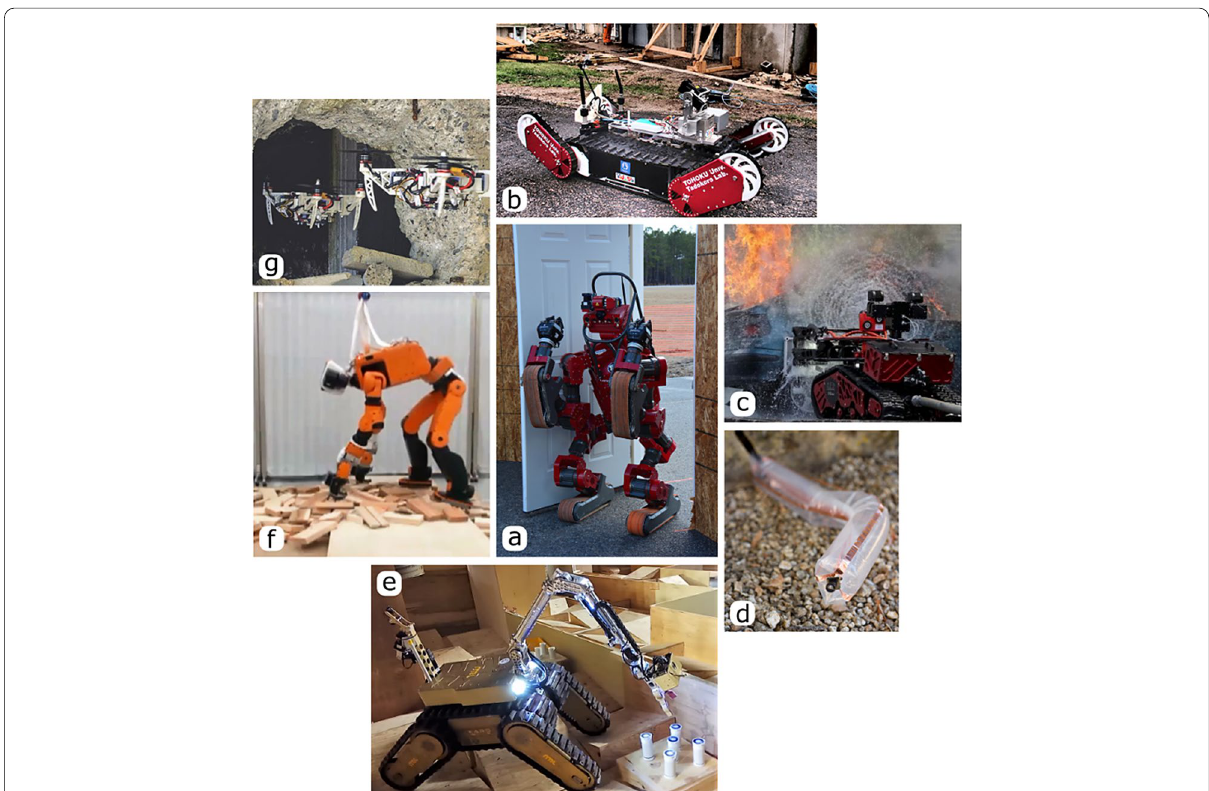
Fig. 1 Response robots in mission: a CHIMP robot performing a DARPA robotic challenge task [14], b Quince rescue robot in a disaster site [15], c Shark Robotics’ Colossus robot extinguishing the fire and clearing away debris [16], d Soft growing robot navigating by exploiting the contact with train [17], e Karo rescue robot performing dexterity task at 2017 RoboCup competitions [18, 19], f Honda’s E2-DR walking on scattered debris [20], g Quadcopter developed by Swiss roboticists with retracting propeller arms fitting a narrow gap